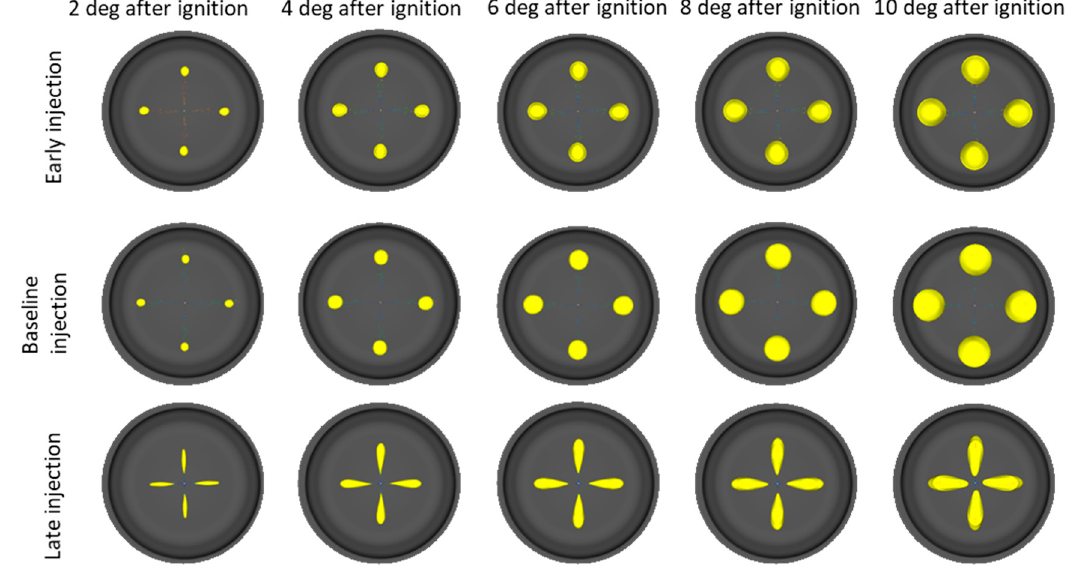
Figure 19. Isosurface of the progress variable for the SoC variation (top down view of the piston).